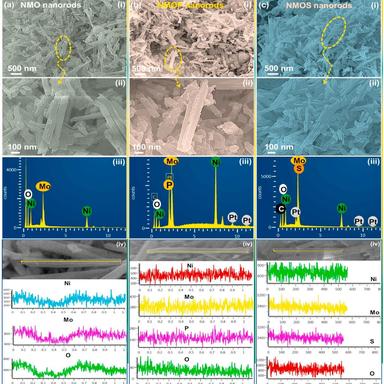
(a) (i,ii) FE-SEM images, (iii) EDX spectrum, and (iv) line mapping images of NMO NRs. (b) (i,ii) FE-SEM images, (iii) EDX spectrum, and (iv) line mapping images of NMOP-1:3 NRs. (c) (i,ii) FE-SEM images, (iii) EDX spectrum, and (iv) line mapping images of NMOS-1:3 NRs.